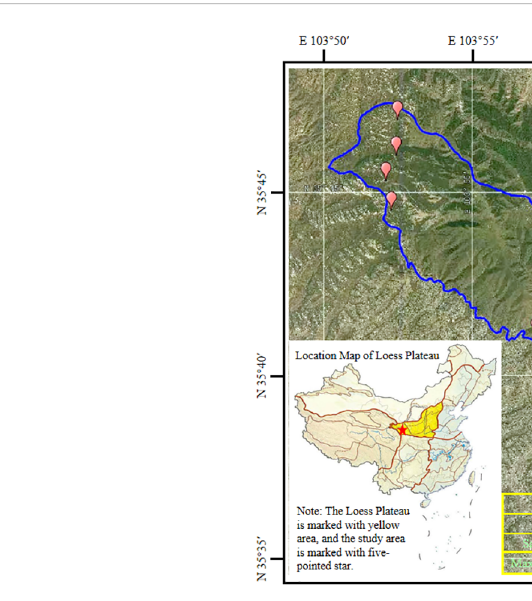
FIGURE 1 Map of research area and sample plot